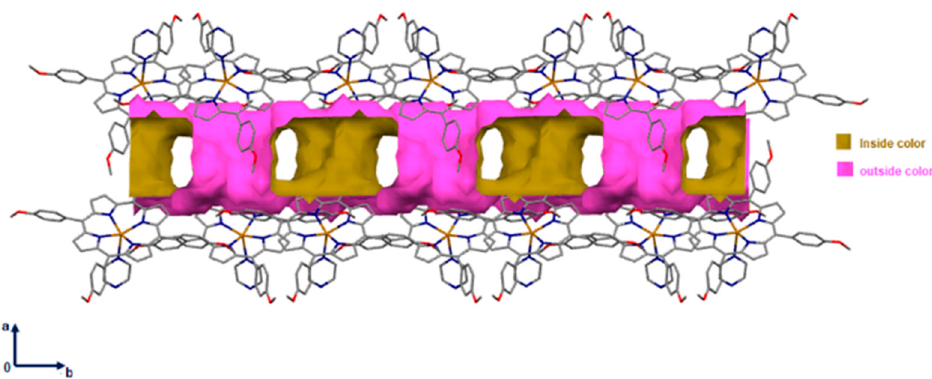
Figure 4. Packing diagram of [Cd(TMPP)(Pyz)] complex ( 1 ) showing voids in the a and the b axis. A ball radius of 1.2 Å and a grid of 0.7 Å were used to calculate the voids.